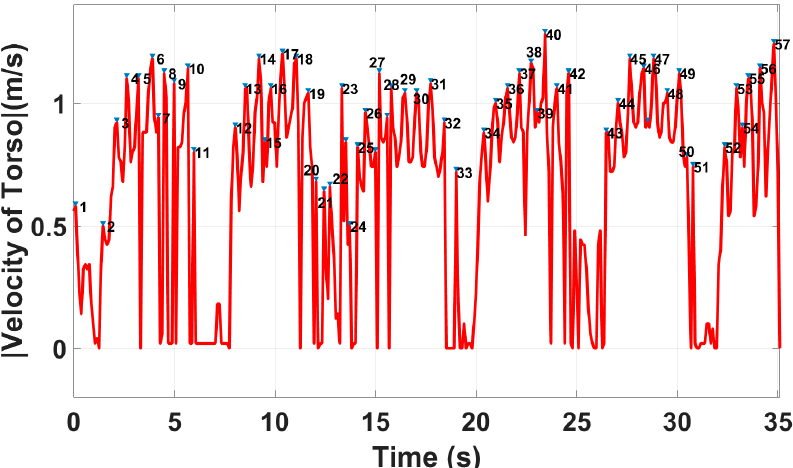
Figure 7. Peak detection algorithm applied to the absolute value of the velocity of the torso using the radar sensor without the lens.